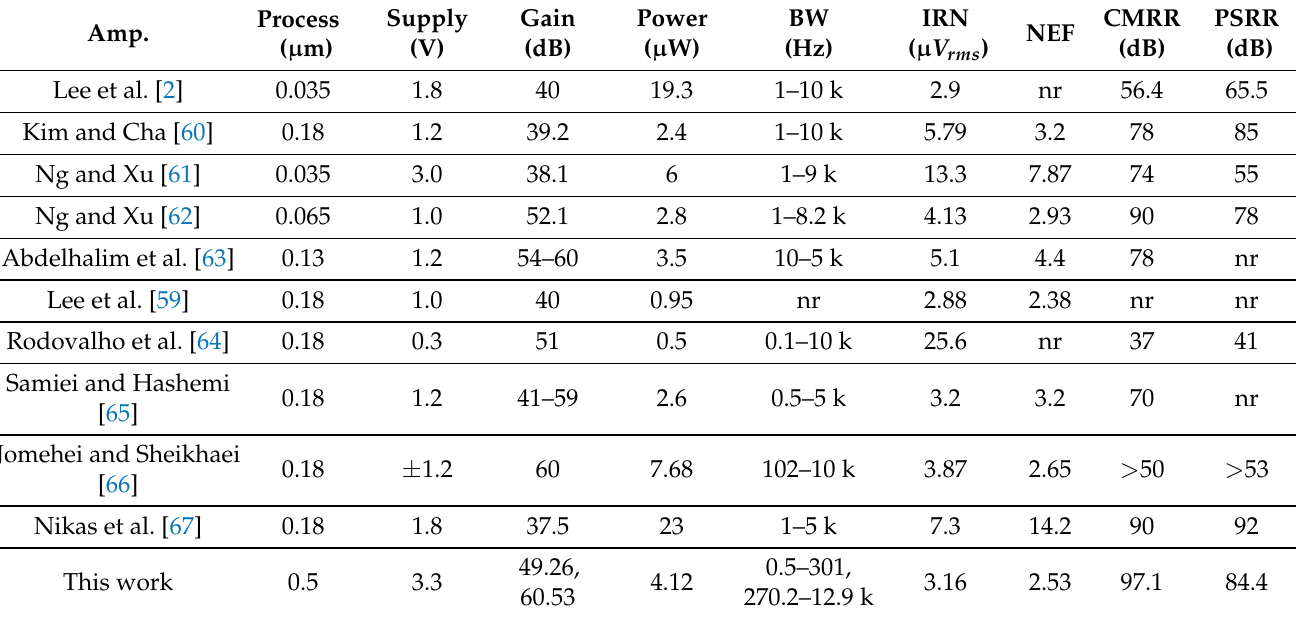
Table 2. Amplifier Performace